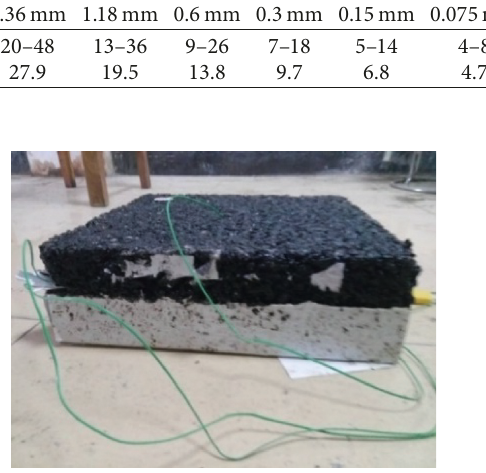
Figure 3: Photograph of a laboratory test